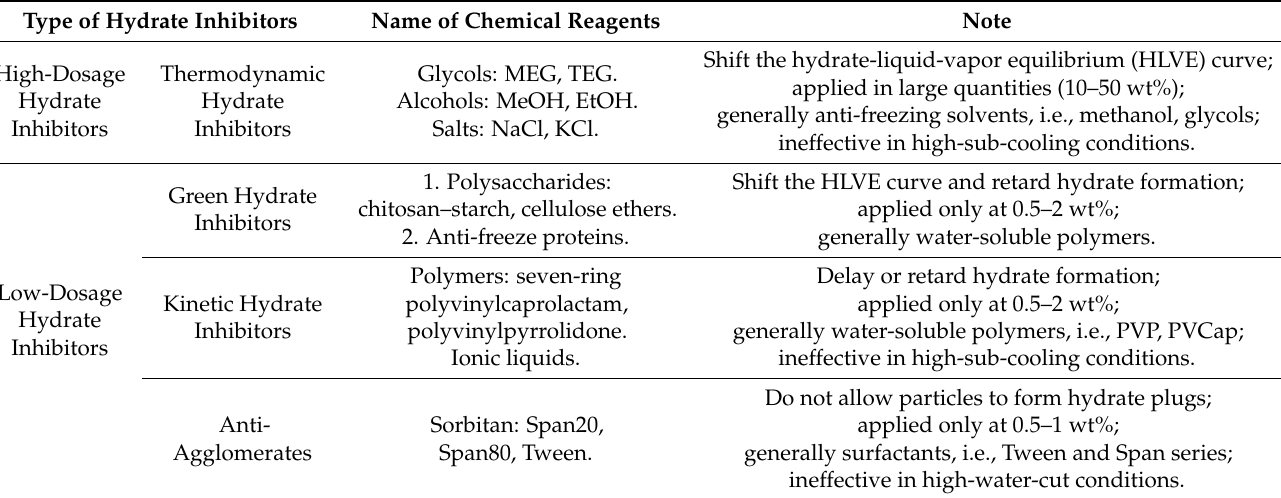
Table 1. Inhibitors of gas hydrate